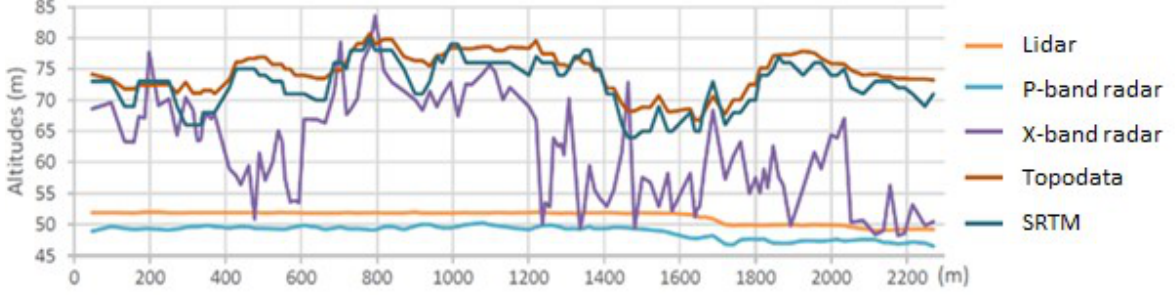
Figure 6. Elevation profiles of DEMs along a river in area